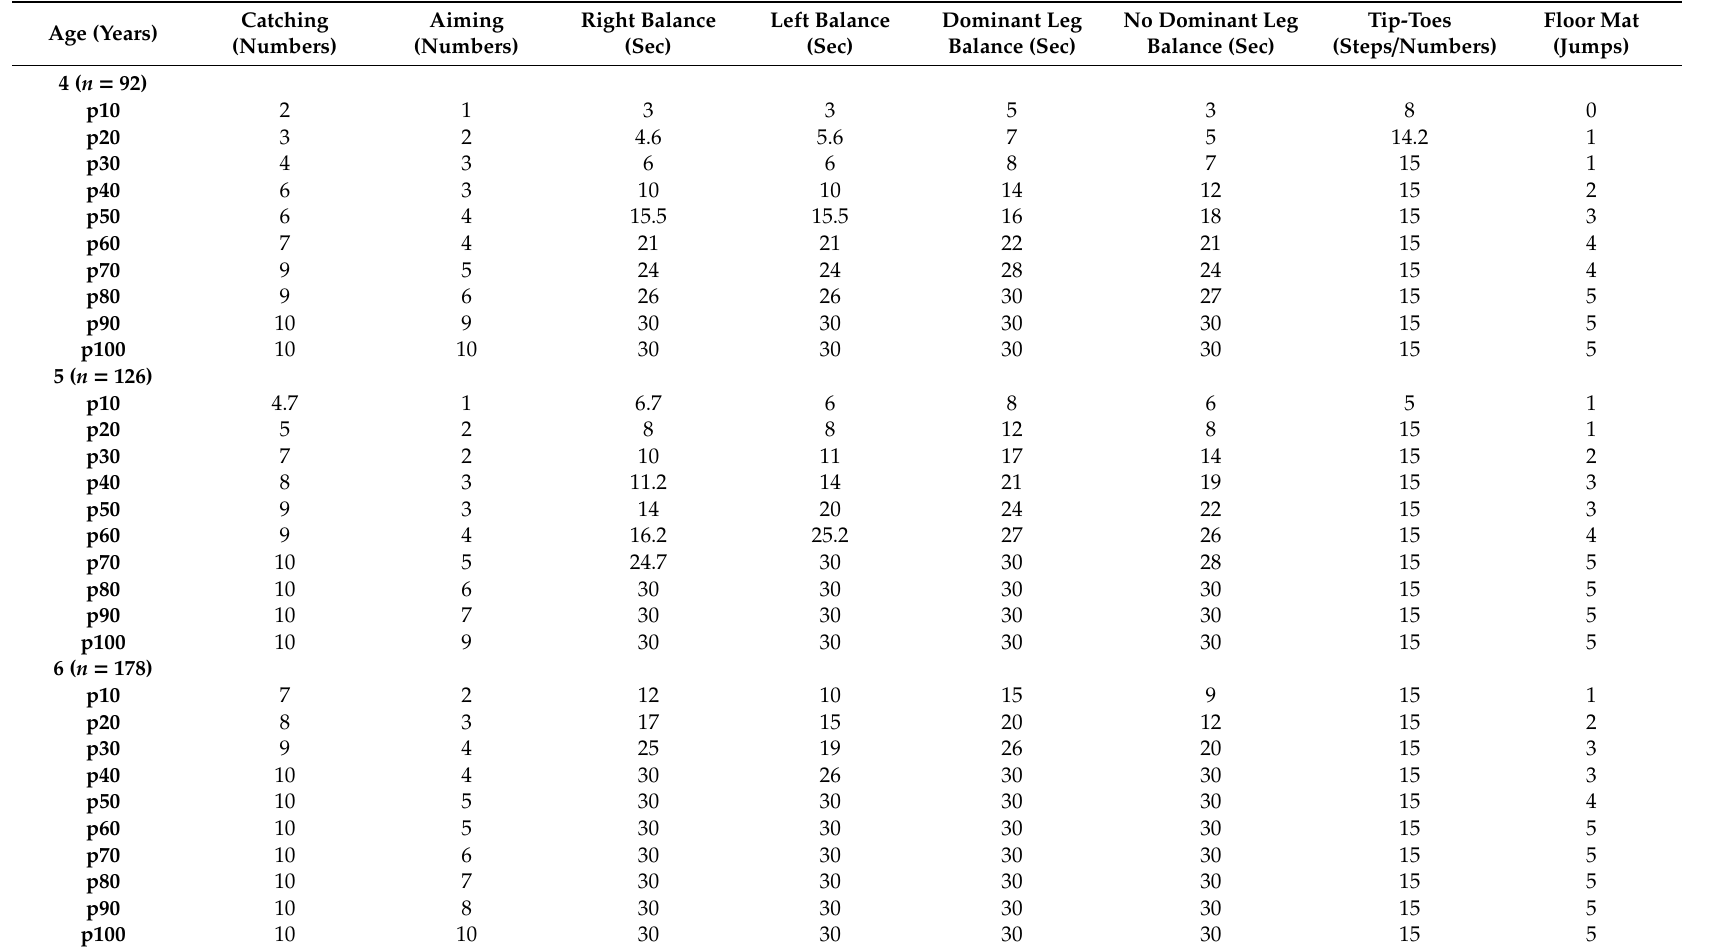
Table 6. Percentile values for girls in gross motor